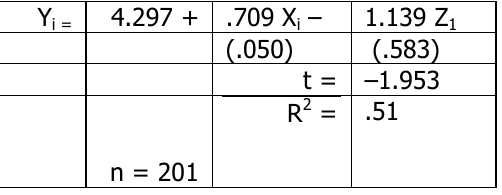
NOBAGS General Aggression – Regression Results, Coefficients (Standard